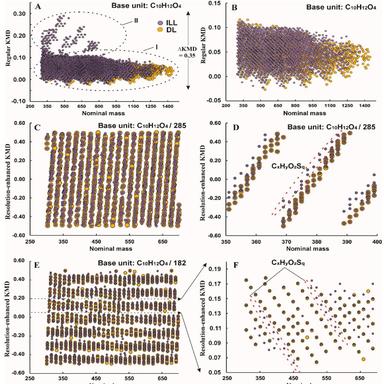
Comparison of KMD (A, B) and REKMD plots with X = 285 (C, D) and 182 (E, F) for ILL (violet dots) DL (orange dots) preparations.